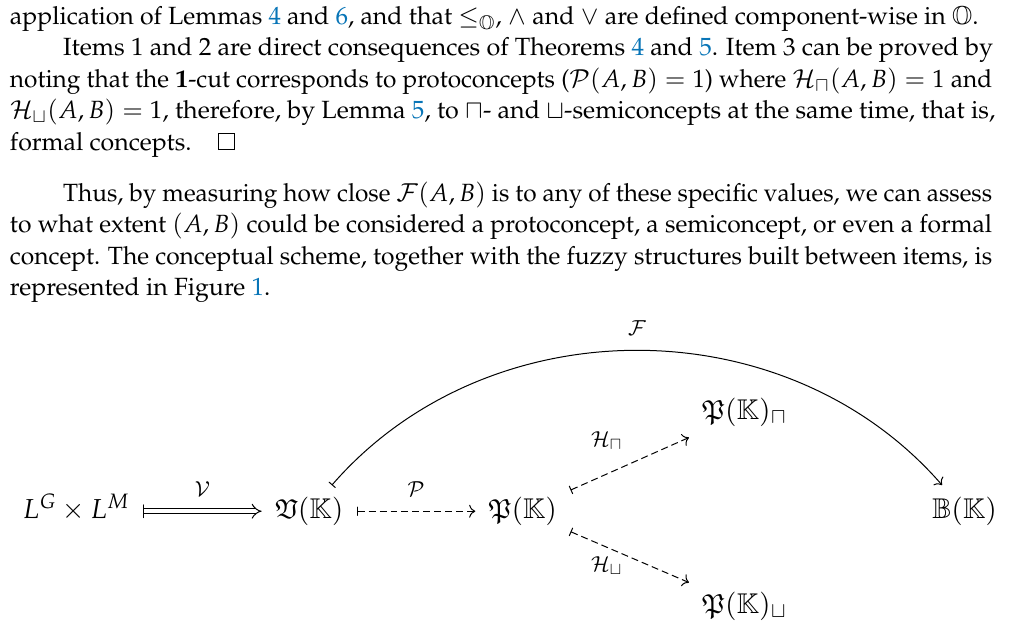
Figure 1. L -fuzzy lattice and L -fuzzy algebras defined in this work. A double solid line stands for the L -fuzzy lattice, simple dashed lines represent L -fuzzy algebras, and a simple solid line represents the O -fuzzy algebra whose cuts are P ( K ) , P ( K )